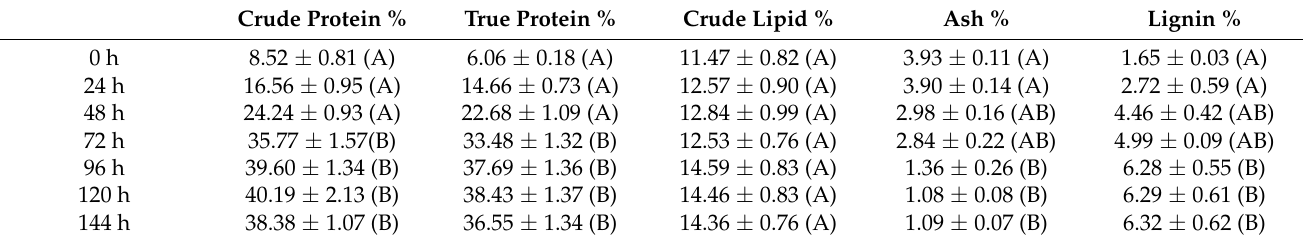
Table 1. Crude and true protein, crude lipid, ash, and lignin percentage at different fermentation time. Crude Protein % True Protein % Crude Lipid % Ash